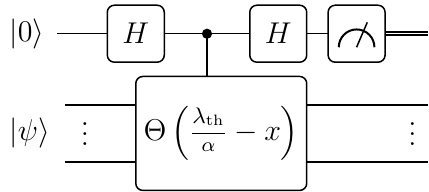
FIG. 8. The circuit that, upon measuring the auxiliary qubit, can be used to solve the eigenvalue threshold problem with high probability as in Algorithm